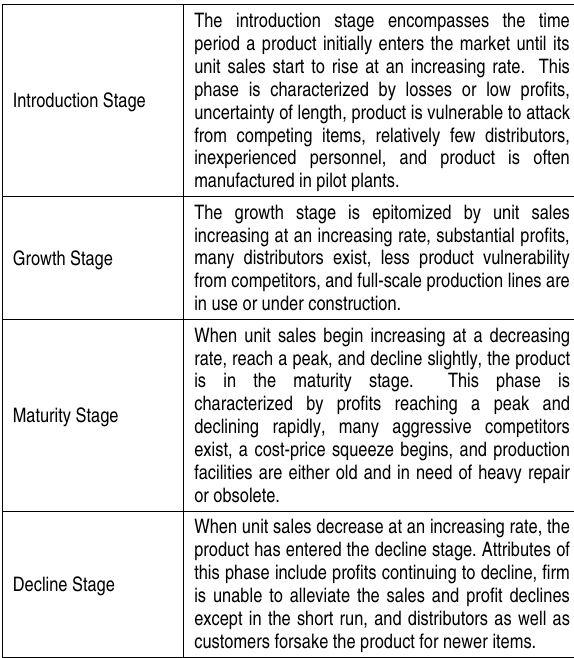
Table 1. Major characteristics of each product